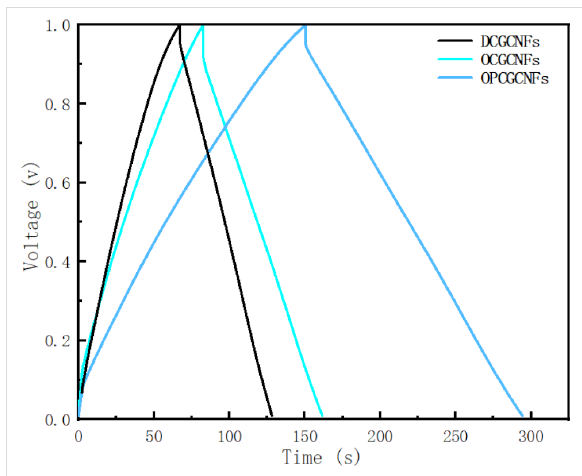
Figure 6: Charge/discharge curves of samples in a 6 M KOH elec- trolyte solution.